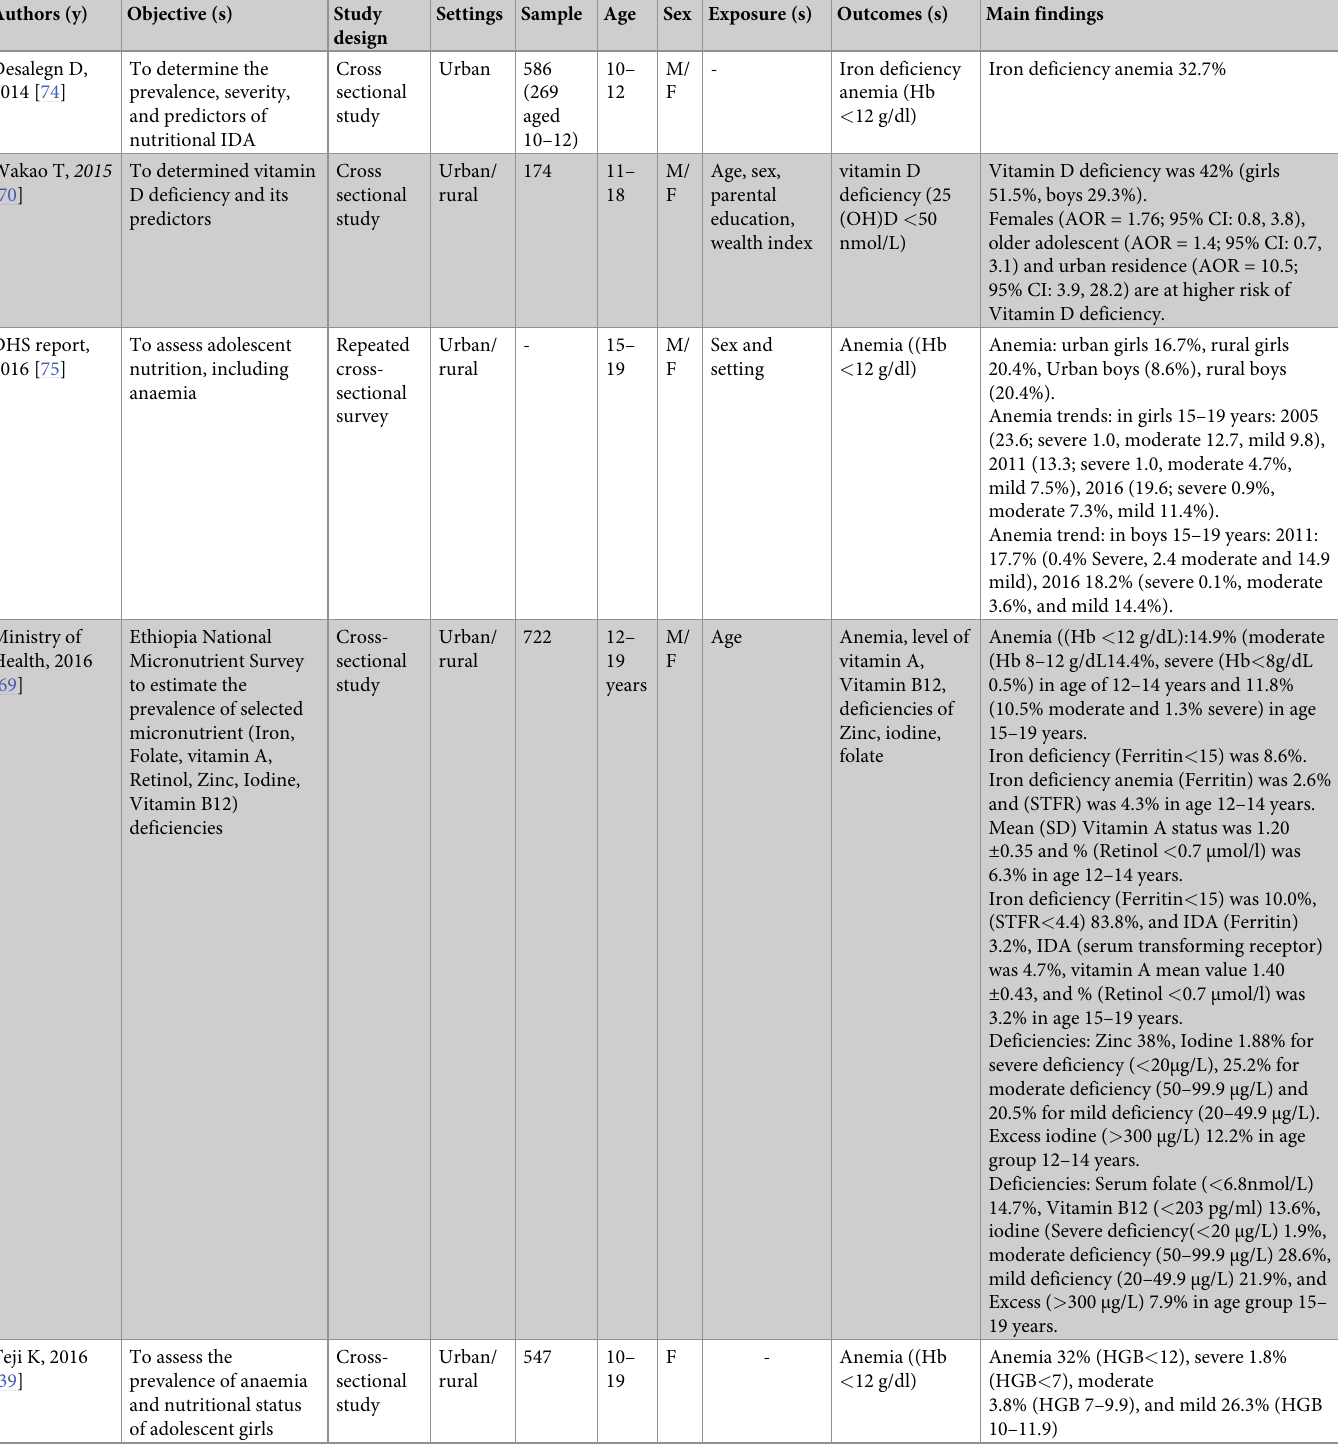
Table 2. Studies focusing on